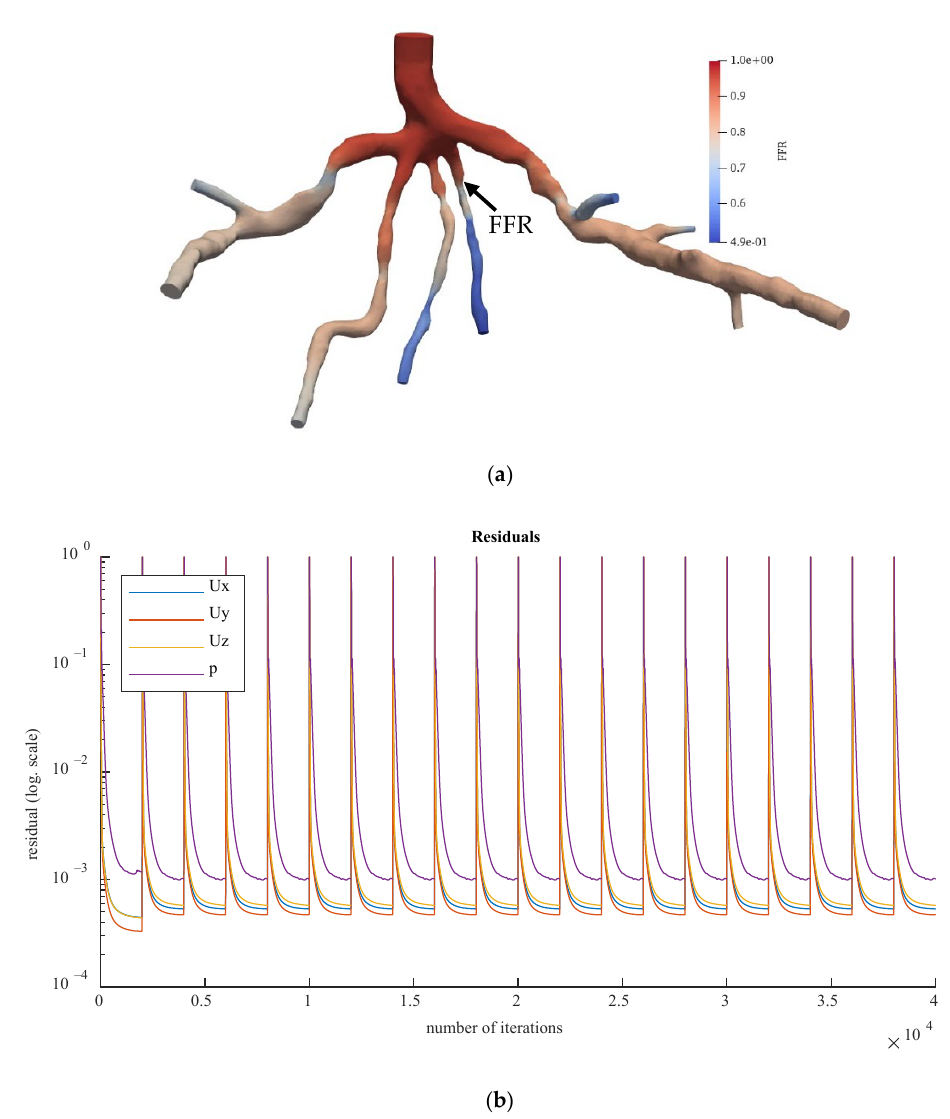
Figure 15. ( a ) FFR distribution with shape of CT209 steady-state PBA model and ( b ) PBA residual history .